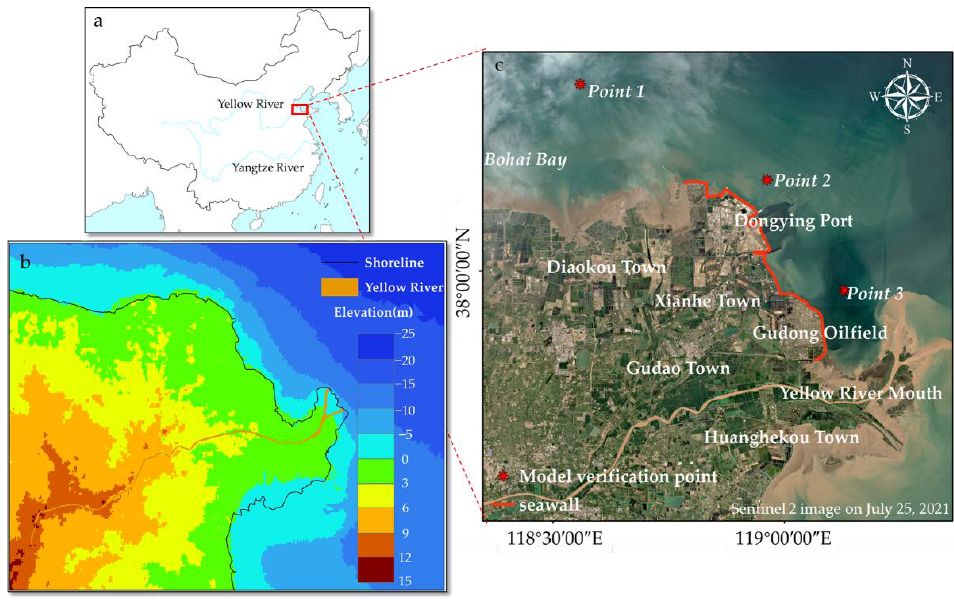
Figure 1. Map of the study area: ( a ) location of the Yellow River Delta (YRD); ( b ) elevation of the delta; and ( c ) satellite images of the YRD region.